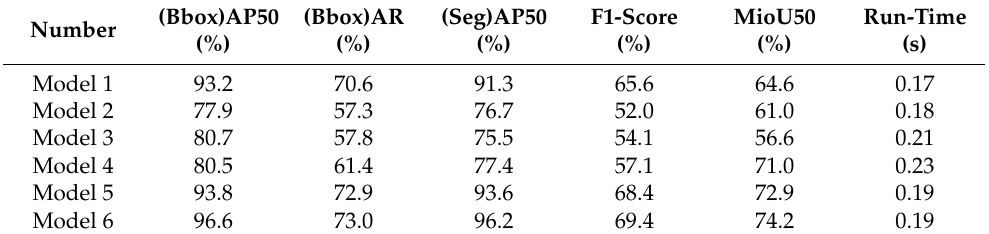
Table 6. Evaluation results of different model on citrus crown